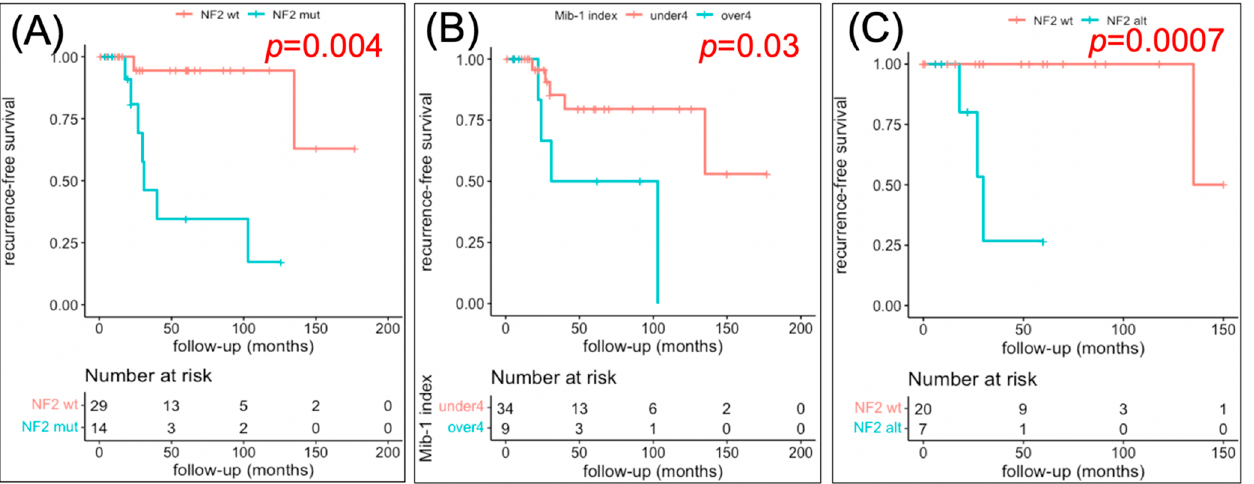
Figure 2. Kaplan–Meier plots of time to recurrence. ( A ) NF2 alteration/22q loss vs. wild-type NF2 /22q. RFS was significantly shorter in patients with NF2 alteration/22q loss ( p = 0.004). ( B ) MIB-1 LI > 4 vs. < 4. RFS was significantly shorter in patients with MIB-1 LI > 4 ( p = 0.03). ( C ) NF2 alteration/22q loss vs. wild-type NF2 /22q in patients with GTR. RFS was significantly shorter in patients with NF2 alteration/22q loss ( p = 0.0007). GTR: gross-total resection. Table 3. Multivariate analysis of tumor recurrence.